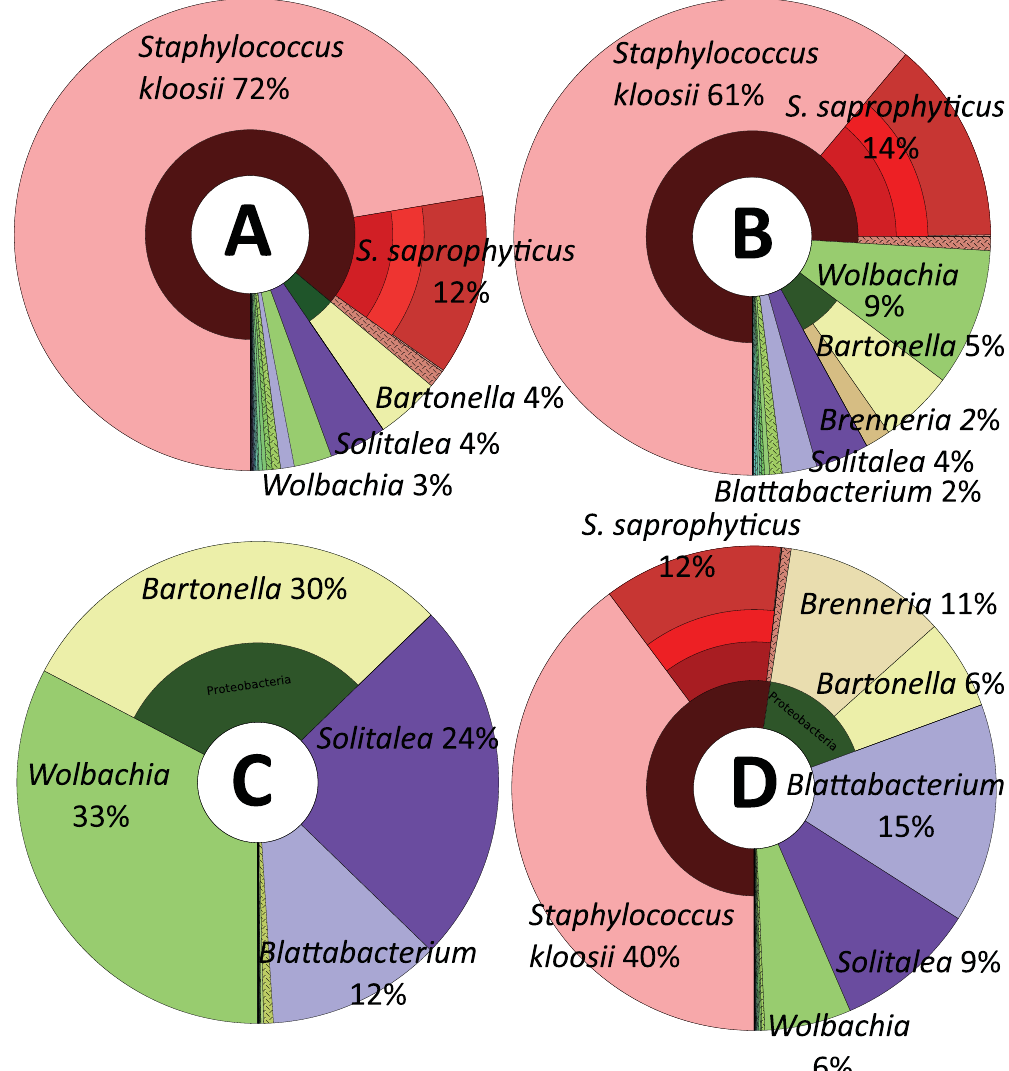
Figure 1. The Krona projections of bacterial taxa found in the samples of predator ( N. cucumeris ) and prey ( T. putrescentiae ) mites. ( A ) Predatory mite ( N. cucumeris ) from mass-production population; ( B ) predatory mite from a laboratory population with disease symptoms; ( C ) the prey mite ( T. putrescentiae ) population from laboratory culture without the presence of predatory mite (Tyro pure), ( D ) prey mite from culture with the presence of predatory mite in mass